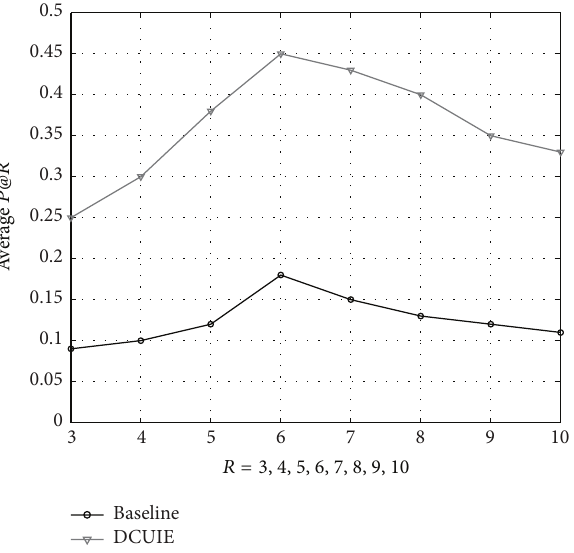
Figure 2: Validation of DCUIE ( 𝛿